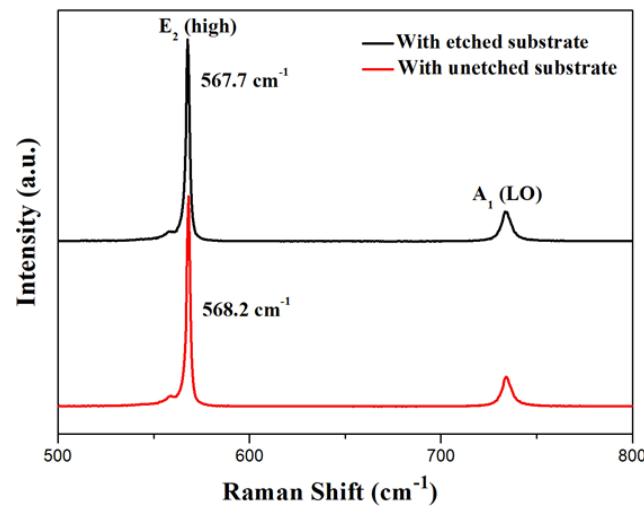
Figure 5. Raman spectra of HVPE–GaN with and without substrate. The wave number of E 2 (high) mode of the HVPE–GaN grown on etched and unetched substrate is detected at 567.7 cm − 1 and 568.2 cm − 1 , respectively.